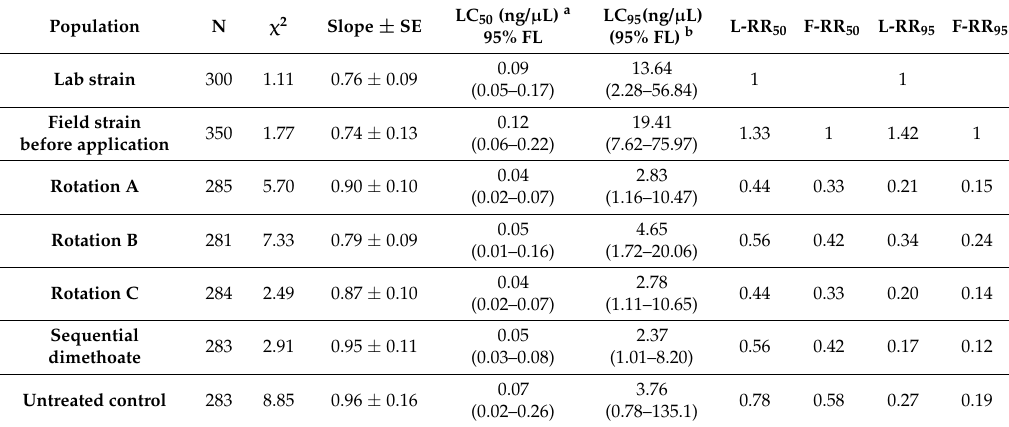
Table 6. Susceptibility of Diaphorina citri adults exposed to abamectin 3% + thiamethoxam 13.9% from field plots under different treatment rotations.